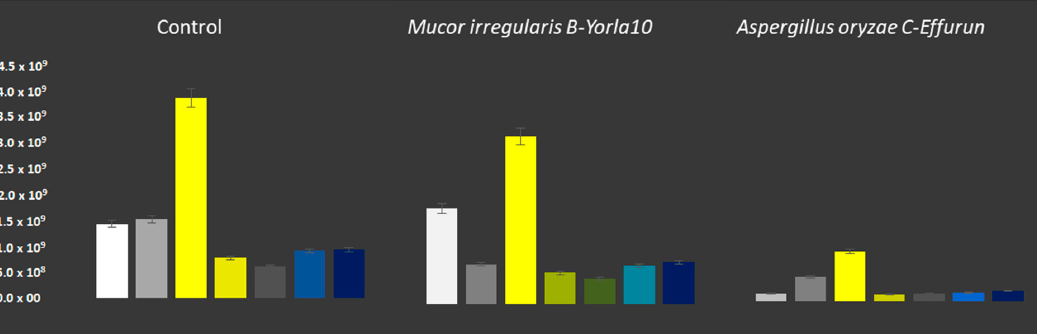
Figure 7. Degradation of hydrocarbon fractions in used engine oil by selected filamentous fungi. Degradation of used engine oil by Mucor irregularis and Aspergillus oryzae . The compounds were grouped in classes of Benzene (yellow), Naphthalene and Indene (dark-yellow), Dimethyl-biphenyl (brown), Naphthalene and substituents (blue), the group of Anthracene, Fluorene and Phenanthrene (dark-blue), Short-chain alkanes (white) and Long chain alkanes (grey).